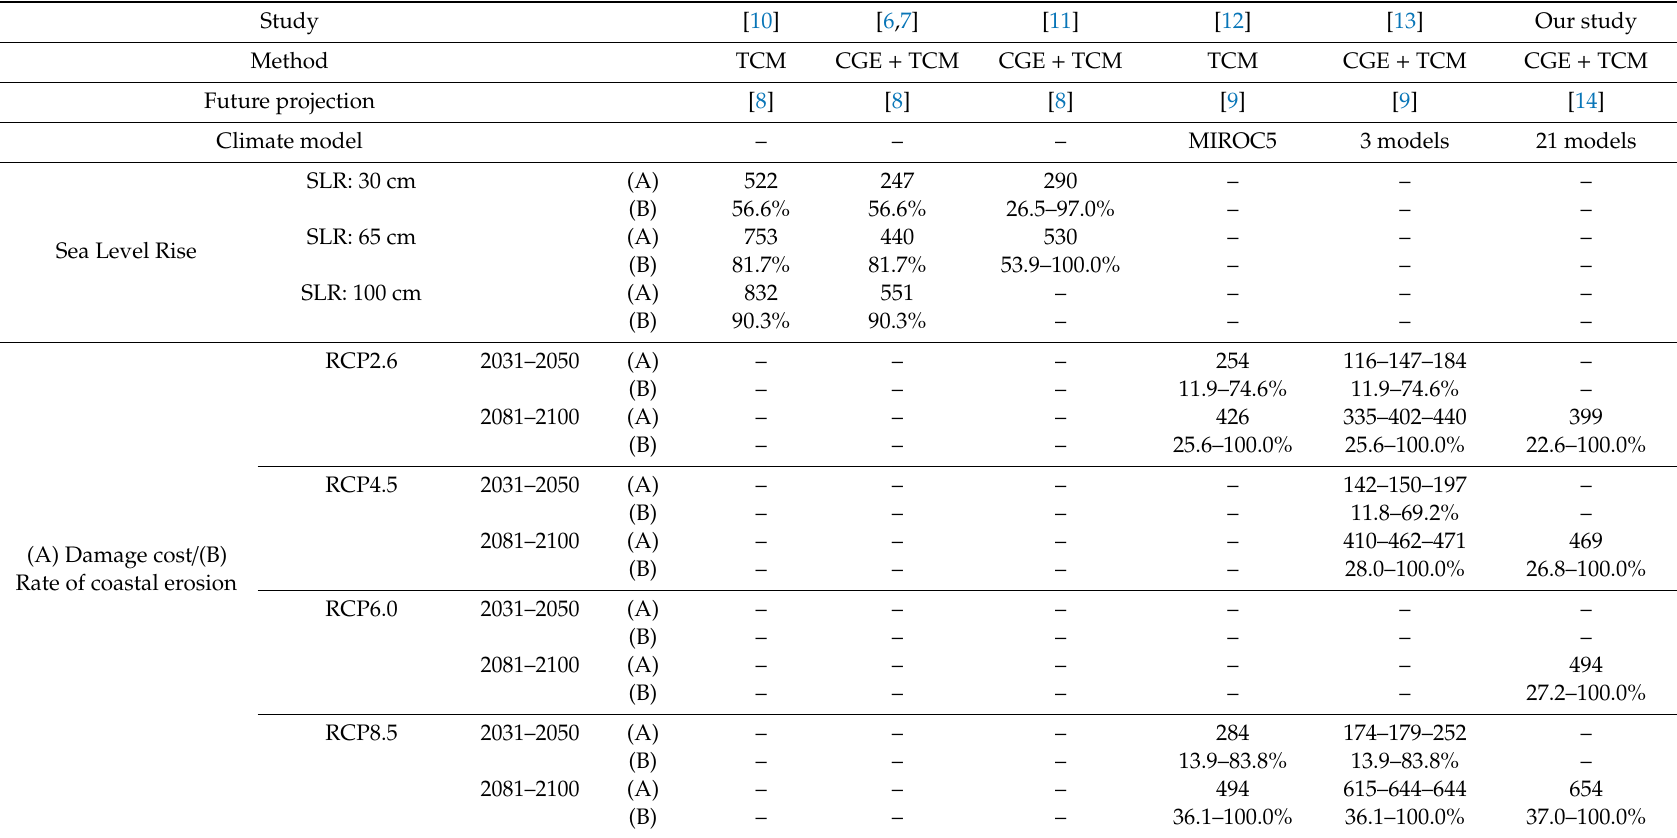
Table 1. Comparison with damage costs reported from earlier